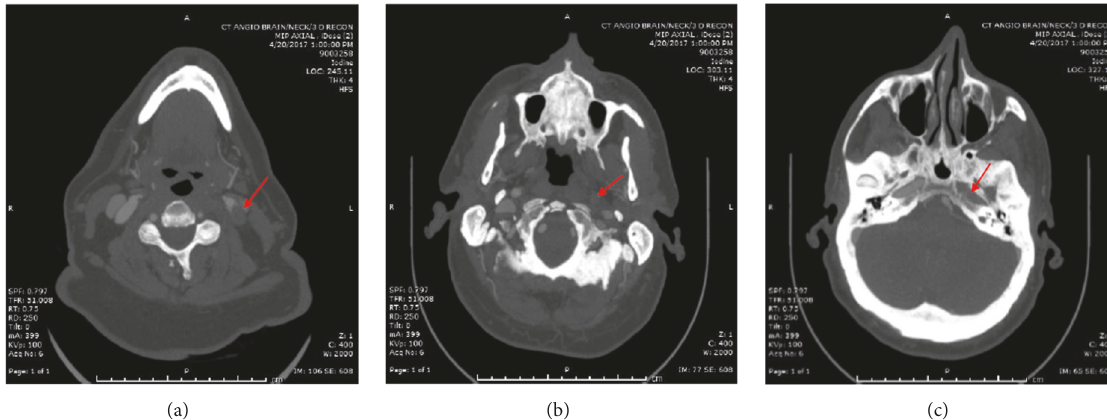
Figure 1: CT angiogram head and neck. Note the occlusion of the left internal carotid artery, starting at the level of the common carotid bifurcation (a), in the neck (b), and in the carotid canal (c).